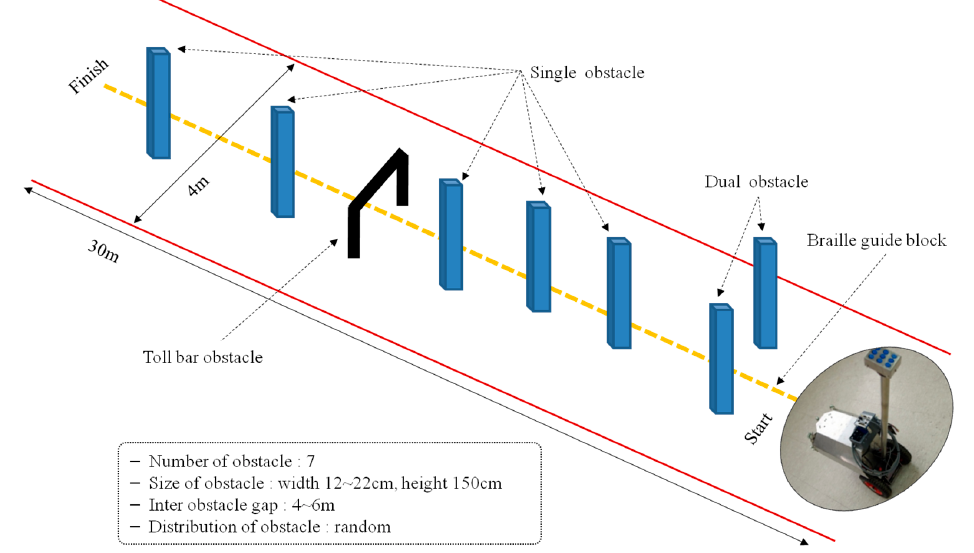
Figure 12. Environmental setup for the second walking test.